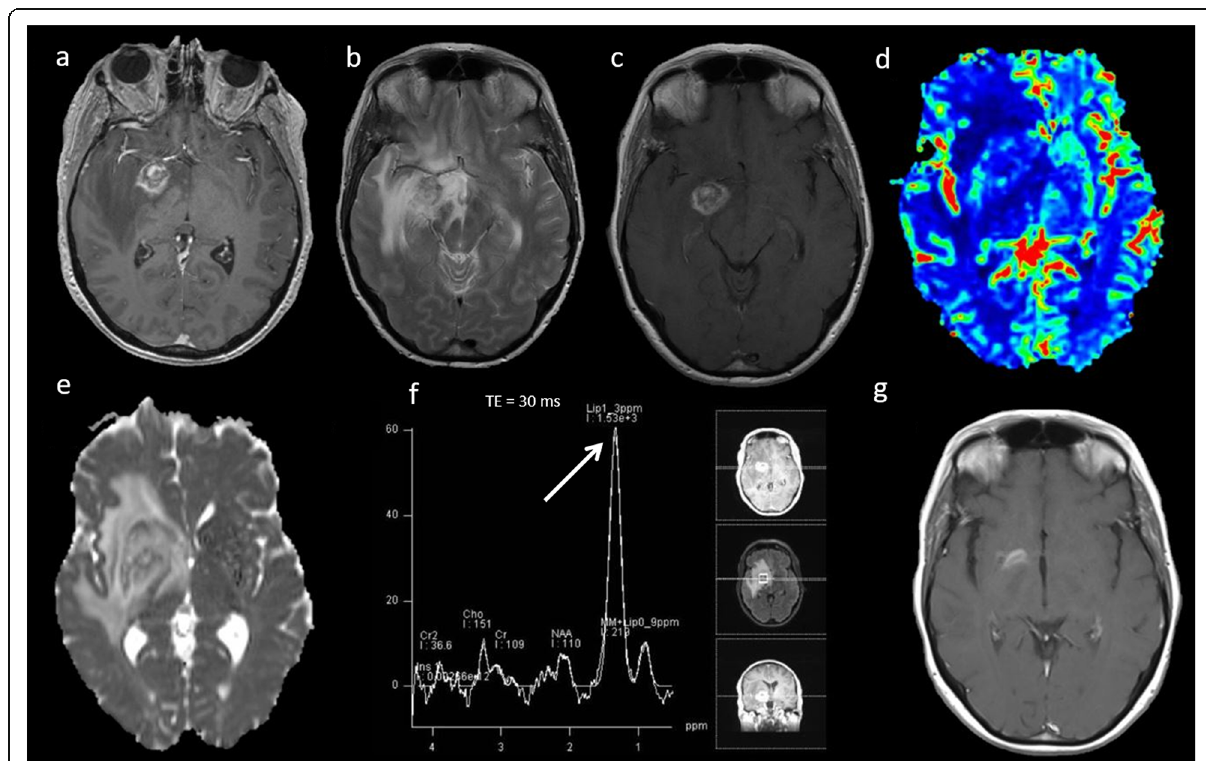
Fig. 10 Brain metastasis — treatment effect. Melanoma metastasis. a Enhancing lesion in the right basal ganglion on axial T1 post-contrast MRI. b , c Post-SRS T2W and post-contrast T1W images shows increase in lesion size and oedema. Multiparametric MRI demonstrates: ( d ) an intermediate rCBV ratio (< 2.1) on PWI, ( e ) a high ADC (1159 × 10 − 6 mm 2 s − 1 ) and ( f ) low Cho/Cr ratio (1.6) and very high lipids (arrow) suggesting necrosis.